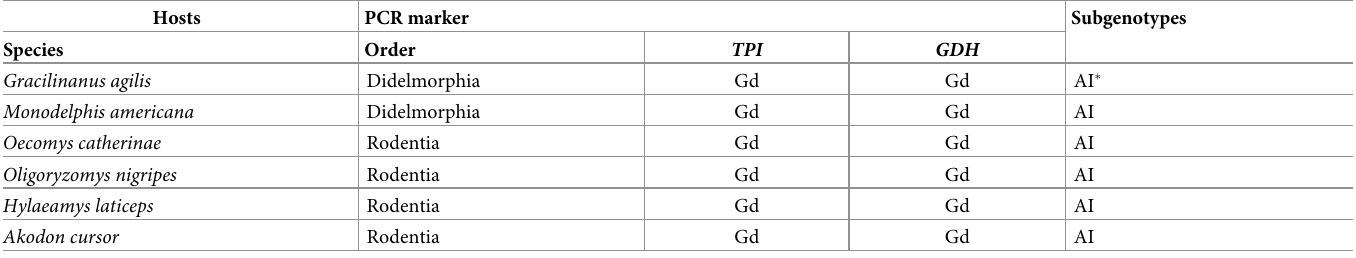
Table 2. Species of Giardia per parasitized host caught in forest and Cabruca areas in southern Bahia, northeastern Brazil. Hosts PCR